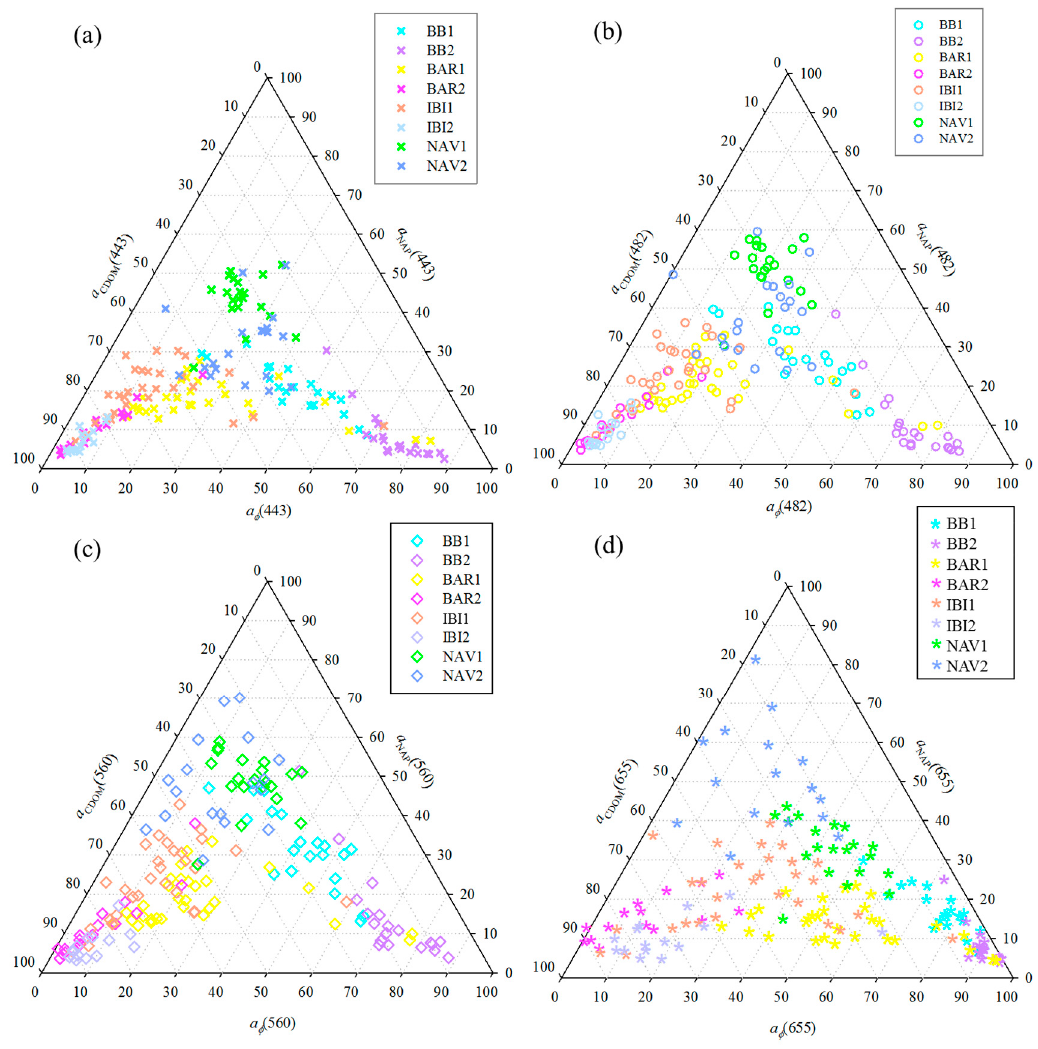
Figure 3. Ternary diagrams of absorption coefficients at 443 ( a ), 482 nm ( b ), 560 nm ( c ) and 655 nm ( d ) from all field surveys (BB1, BB2, BAR1, BAR2, IBI1, IBI2, NAV1, and NAV2). Where a φ is related to phytoplankton absorption, a NAP to non-algae particle absorption and a CDOM is related to the absorption from colored dissolved organic matter.